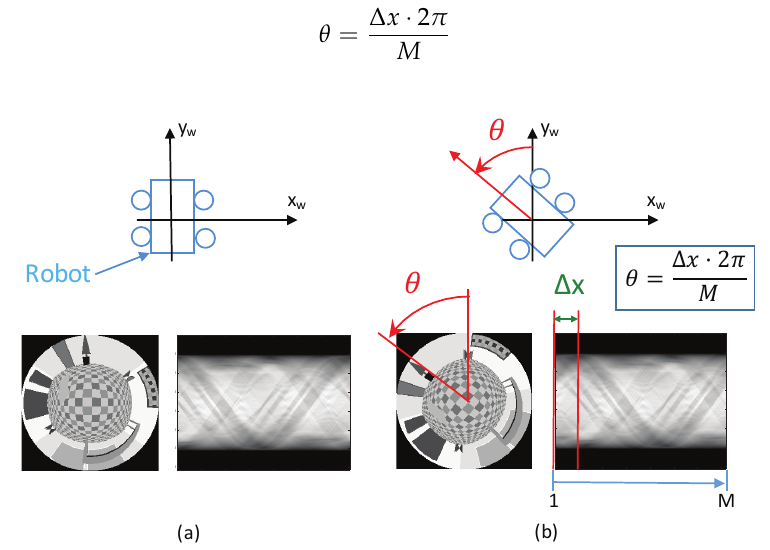
Figure 4. ( a ) Omnidirectional image captured from a specific position of the environment and its Radon transform. ( b ) Omnidirectional image taken from the same location changing only the robot orientation around the z w axis and its Radon transform. A change of the robot orientation around the z w axis produces a shift of the columns of the Radon transform, ∆ x